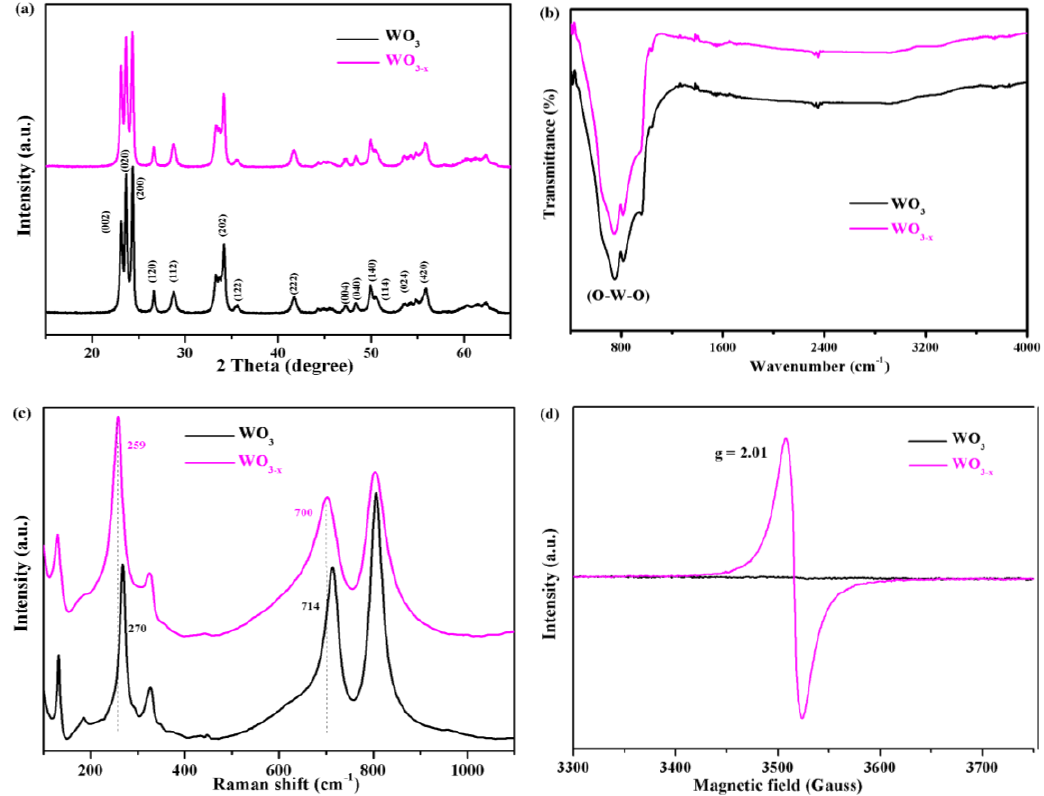
Figure 3. Comparison of the WO 3 and WO 3 − x nanosheets. ( a ) X-ray diffraction (XRD) patterns; ( b ) Fourier-transform infrared spectroscopy (FTIR) spectra; ( c ) Raman spectra and ( d ) electron paramagnetic resonance (EPR) spectra at room temperature.